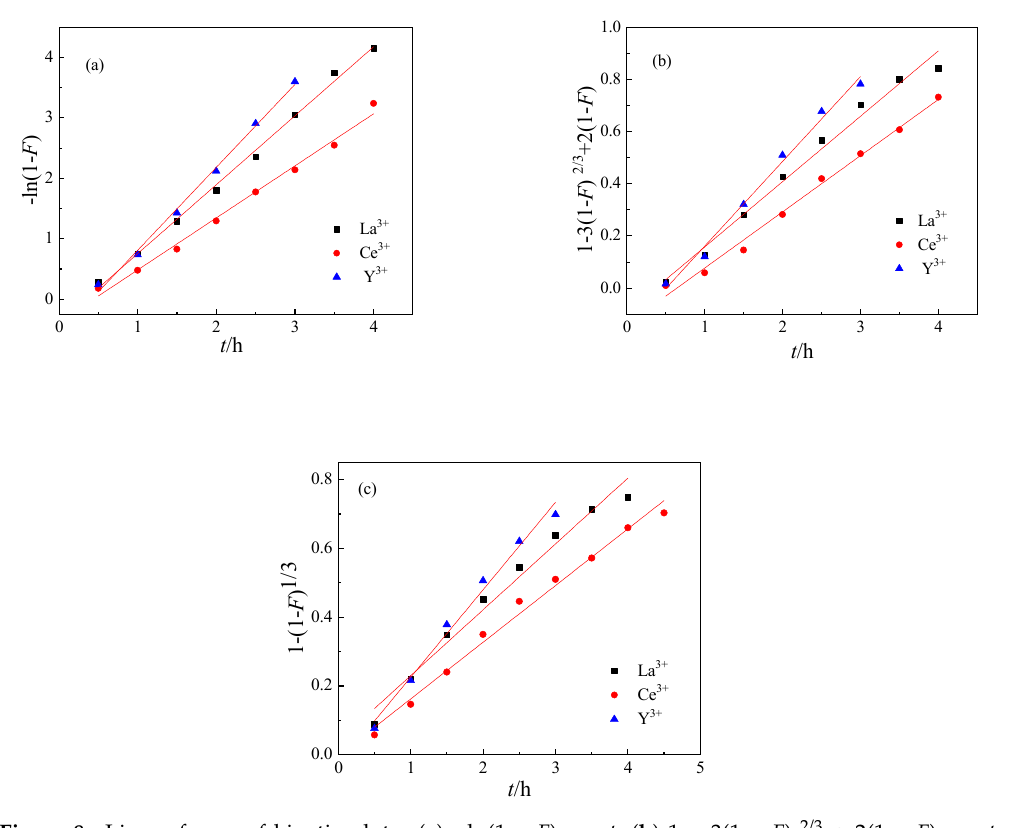
Figure 8. Linear forms of kinetic plots: ( a ) − ln(1 − F ) vs. t ; ( b ) 1 − 3(1 − F ) 2/3 + 2(1 − F ) vs. t ; ( c ) 1 − (1 − F ) 1/3 vs. t.